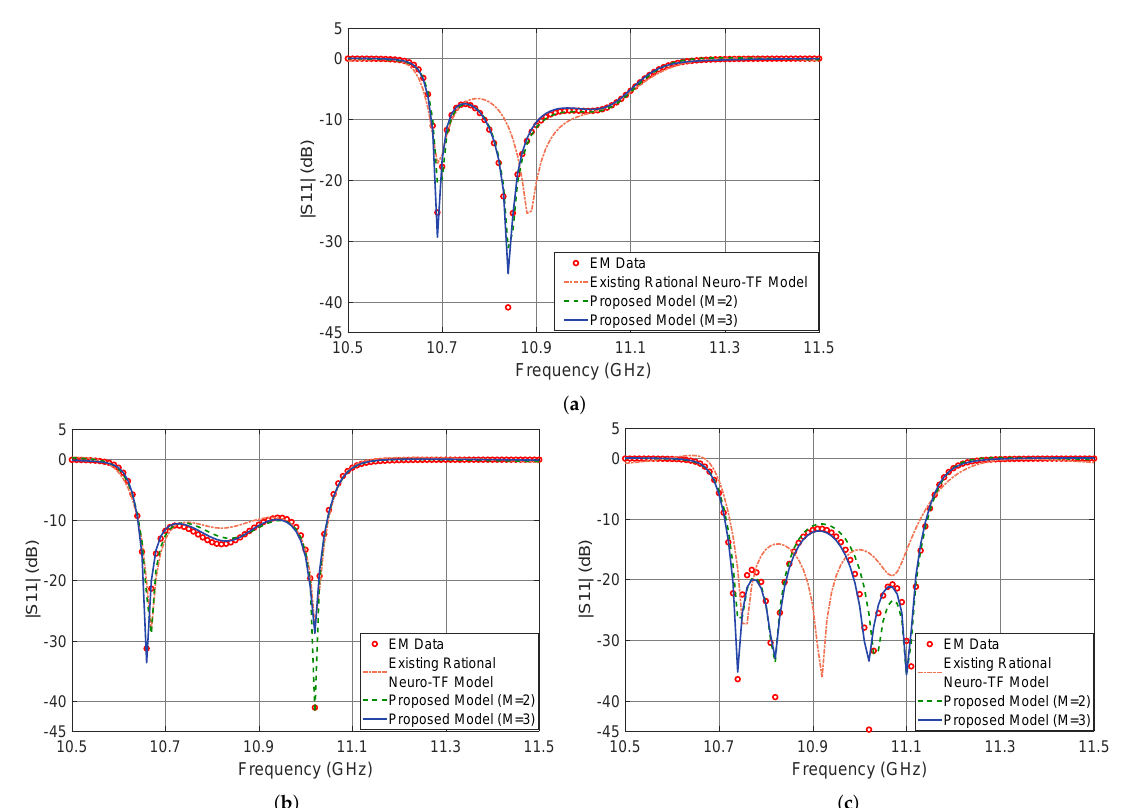
Figure 9. Comparison of magnitude in decibels of S 11 for different modeling approaches and EM data: ( a ) test sample x = [ 3.52 4.46 3.96 3.28 3.07 ] T (mm), ( b ) test sample , x = [ 3.60 4.22 4.20 3.40 3.10 ] T (mm), and ( c ) test sample x = [ 3.36 4.38 4.00 3.36 3.02 ] T (mm) for the four-order bandpass filter example.